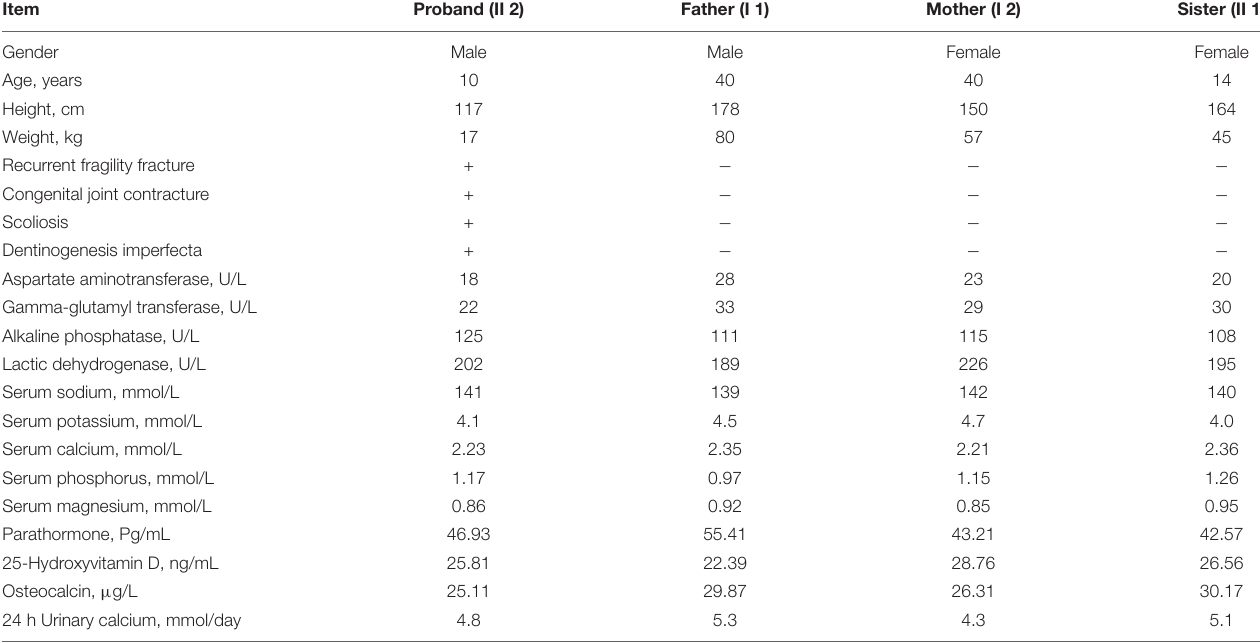
TABLE 2 | Clinical data of proband’s family.